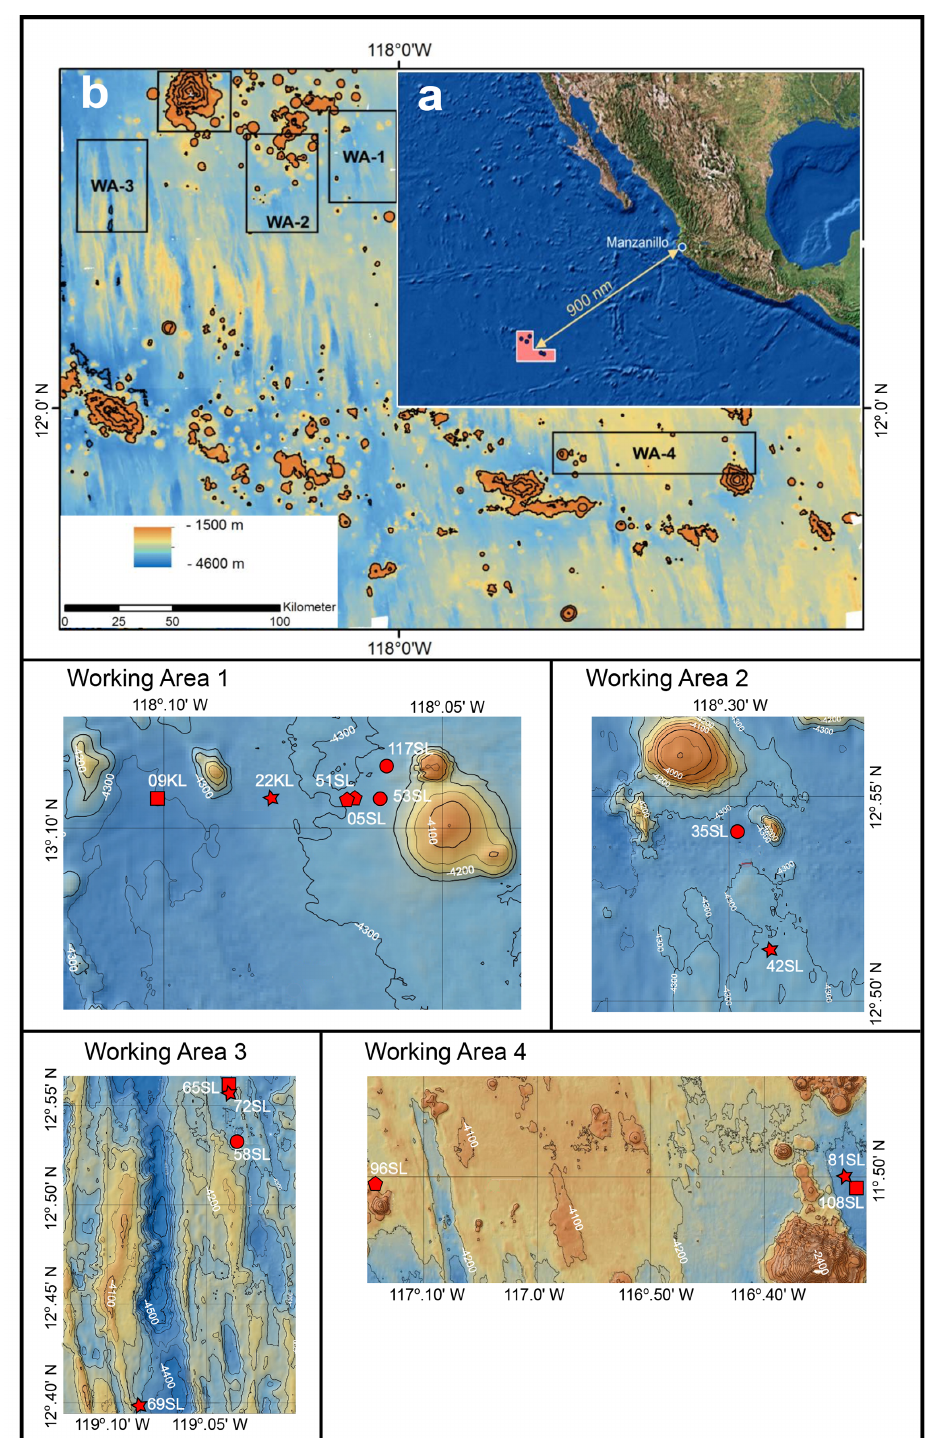
Figure 1. Maps (adapted from Kuhn et al., 2015). (a) Geographical setting. (b) Bathymetric map of the region of investigation with the four working areas indicated. The lower four panel cut-outs of bathymetric maps are of the four working areas with core locations indicated by red dots. Intervals between isobaths for working areas 1 to 3 are 50m and 100m for working area 4. A star signifies cores taken above a fault, a circle signifies cores taken near a seamount, a pentagon signifies cores taken above a fault and near a seamount, and a square signifies cores taken neither close to a seamount nor above a